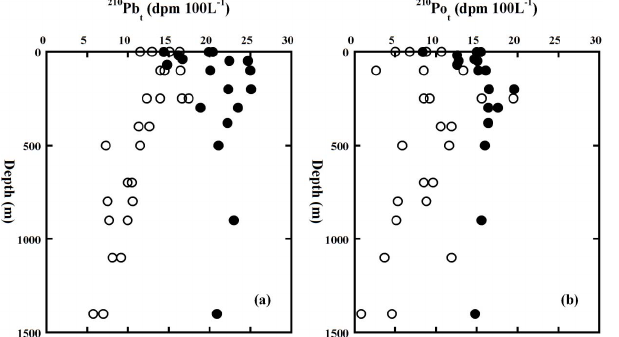
Figure 6. Vertical profiles of the (a) 210 Pb t / 226 Ra ratio and the (b) 210 Po t / 210 Pb t ratio of the four cruises to the SEATS sta- tion. Dashed line at unity indicates the secular equilibrium between daughter and parent